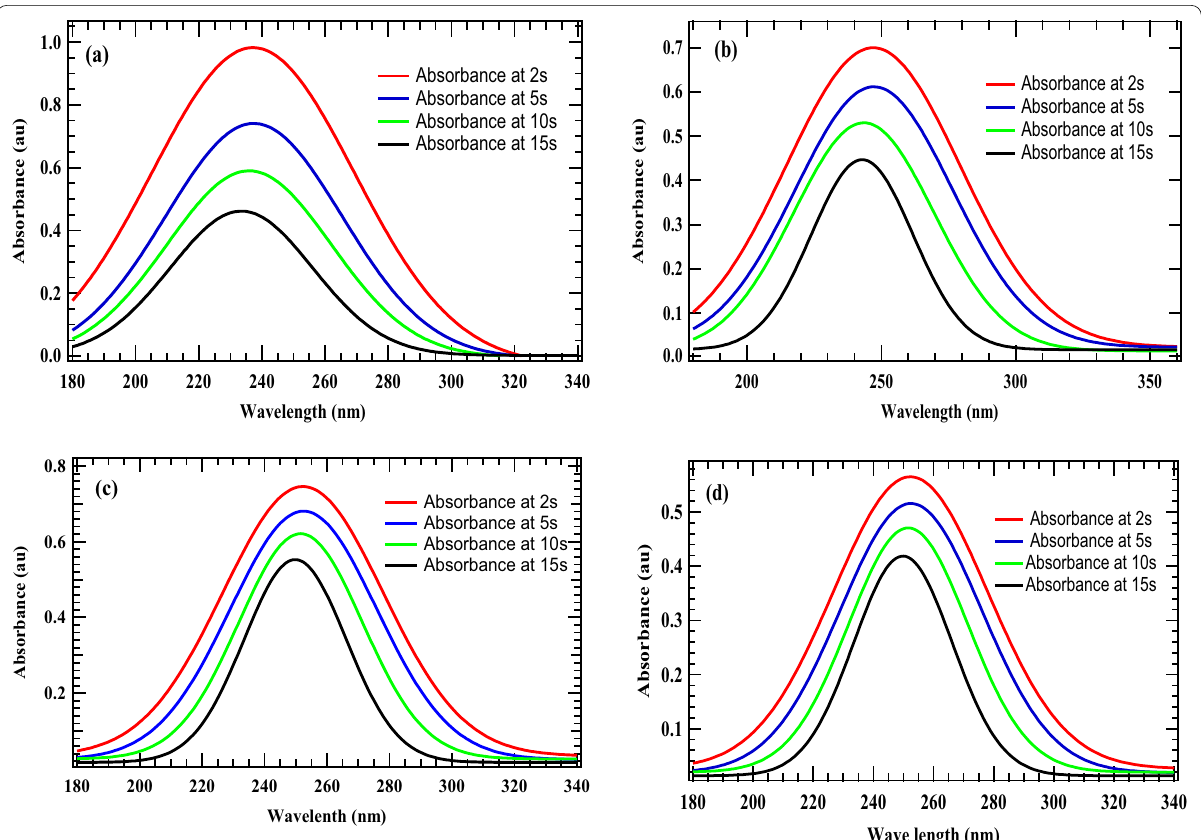
Fig. 6 Absorbance of tobacco chemicals at various puff times: a untreated and b treated MM-R and c untreated and d treated RR-M cigarettes